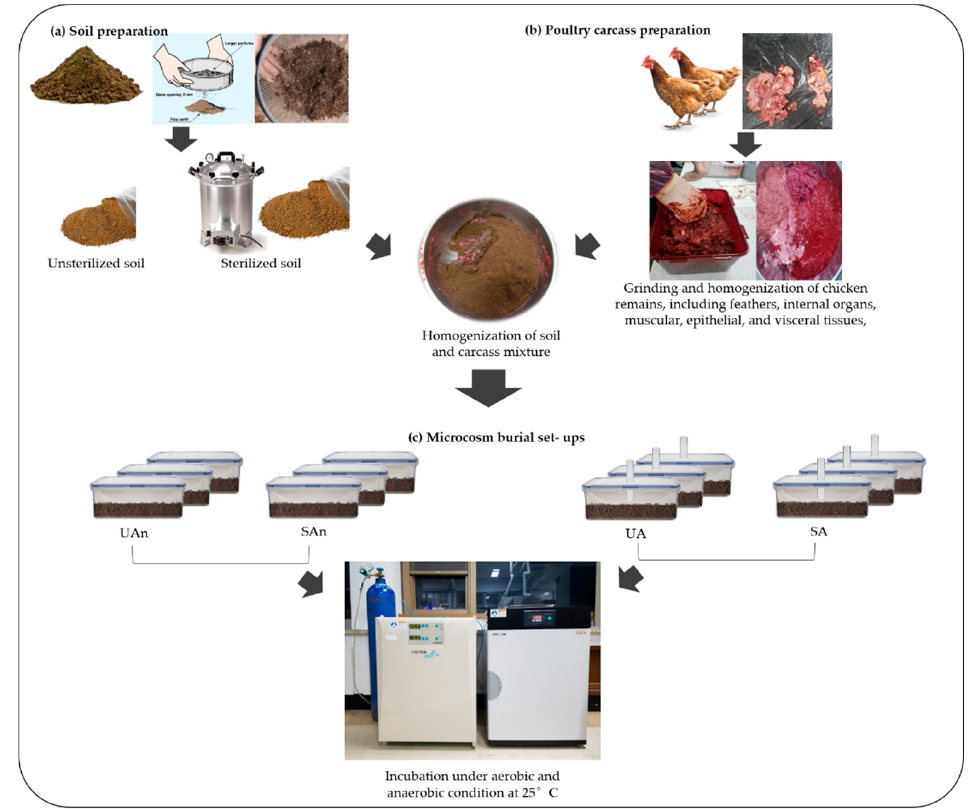
Figure 1. Schematic diagram of the experimental setup. UA, unsterilized soil–aerobic condition; SA, sterilized soil–aerobic condition; UAn, unsterilized soil–anaerobic condition and SAn, sterilized soil–anaerobic condition.